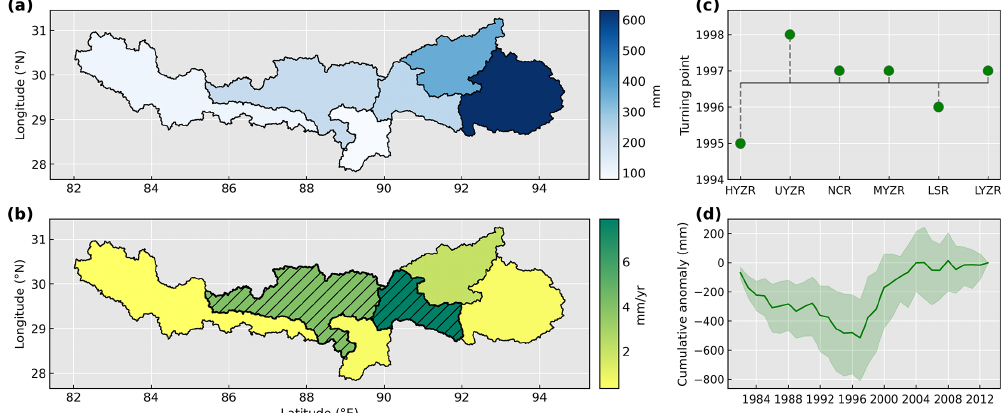
Figure 3. Long-term water yield changes in the entire UBR basin. (a) The annual values calculated by averaging water yield from 1982 to 2013. (b) The temporal trends detected by the Mann–Kendall Sen’s slope method. The black hatching represents statistically significant ( p < 0 . 05) trends. (c) The turning points detected by the Pettitt method. (d) The cumulative anomaly curve of water yield. The solid green line represents the ensemble expectation of cumulative anomaly curves of water yield in the entire UBR basin (green shading).